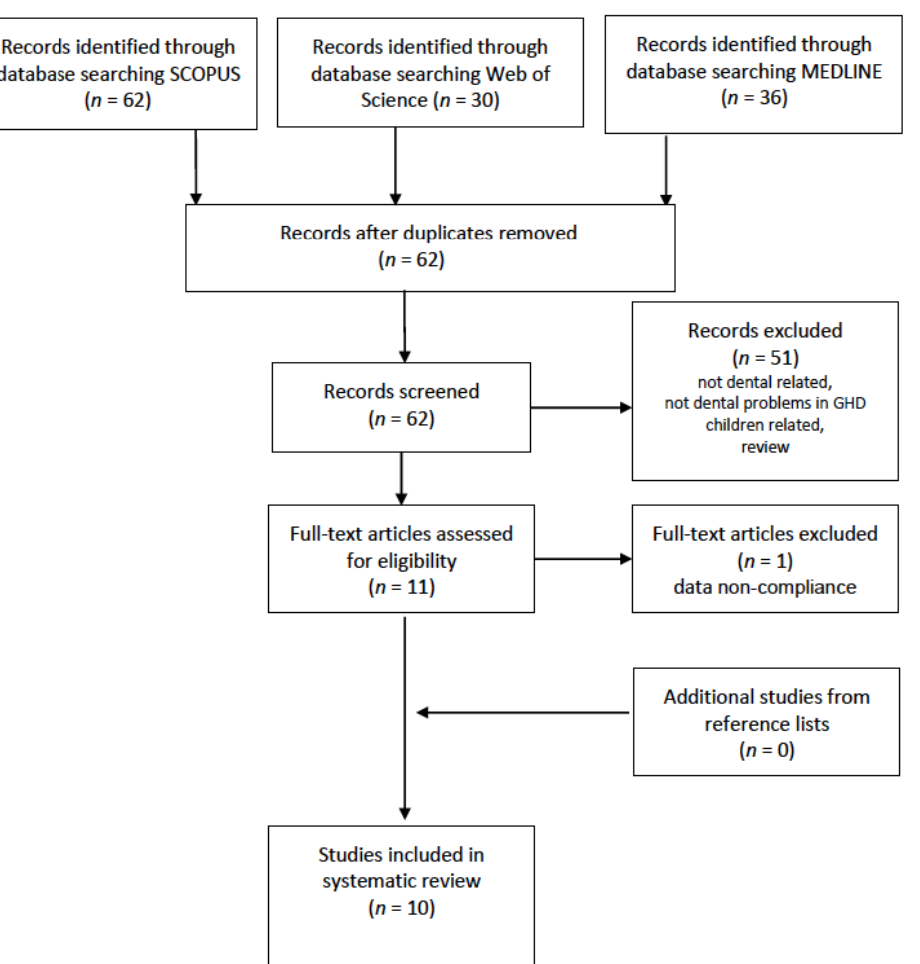
Figure 1. PRISMA flowchart of the study selection process.